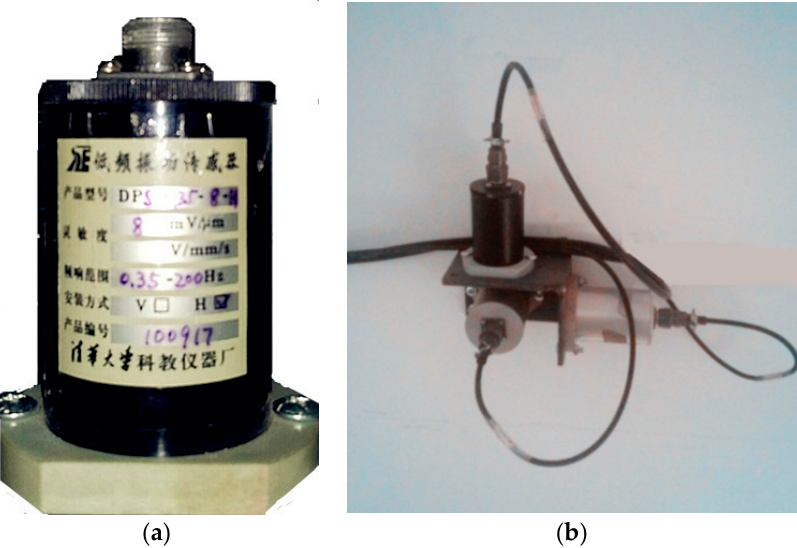
Figure 4. Vibration displacement sensors used in field tests: ( a ) Close-up; and ( b ) Field installation photo.